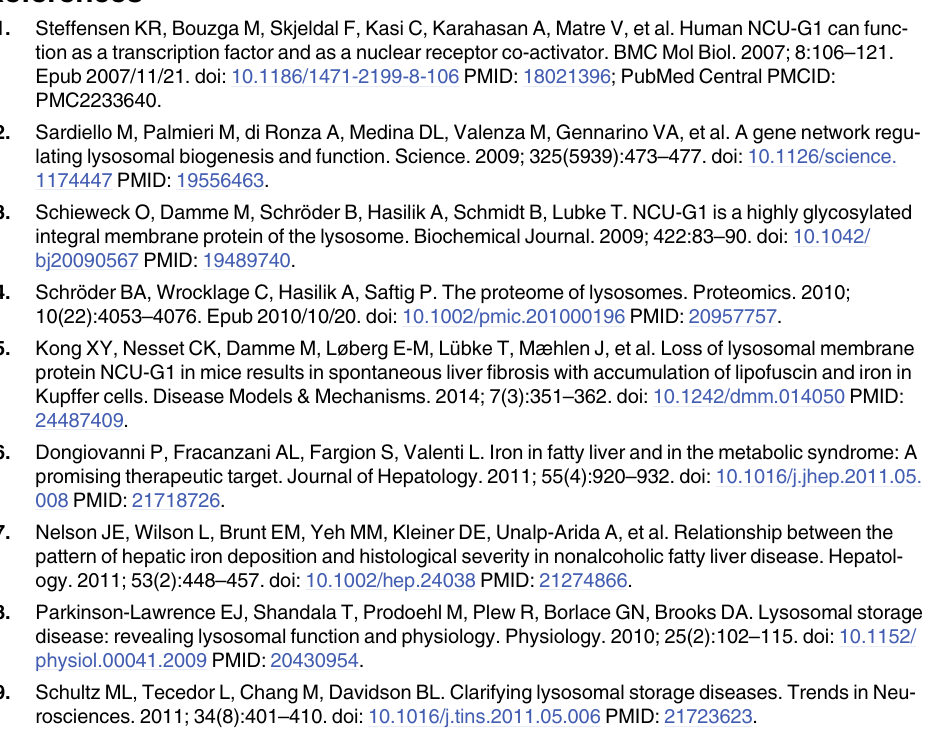
S1 Fig. Verification of disrupted GLMP expression in Glmp gt/gt mice. Lysosome-enriched fractions from mouse kidney and liver after tyloxapol treatment were used to verify the ablation of GLMP expression in Glmp gt/gt mice. LAMP1 served as loading